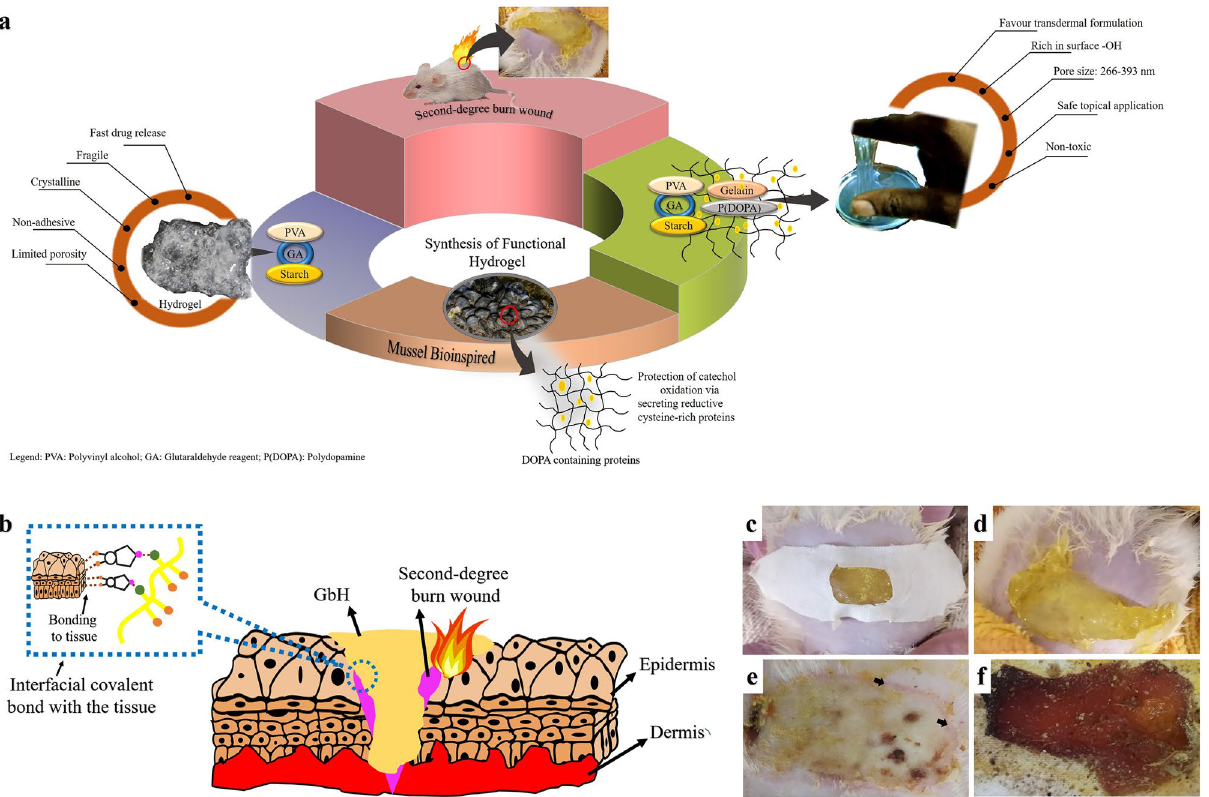
Figure 8. Highlights of the GbH in the current research: ( a ) Development of bioinspired gelatin-based diverse surface sticky hydrogel for second-degree burn wound care; ( b ) Schematic of the surface interaction of the catechol group with the burn wound area; ( c ) soft wound patch interaction with wound tissue; soft wound patch; ( d ) QH placed on second-degree burn wound; ( e ) Observable wound repair on day 3 (arrow) of dressing and ( f ) Absorption of exudates: a hallmark of the ideal hydrogel.